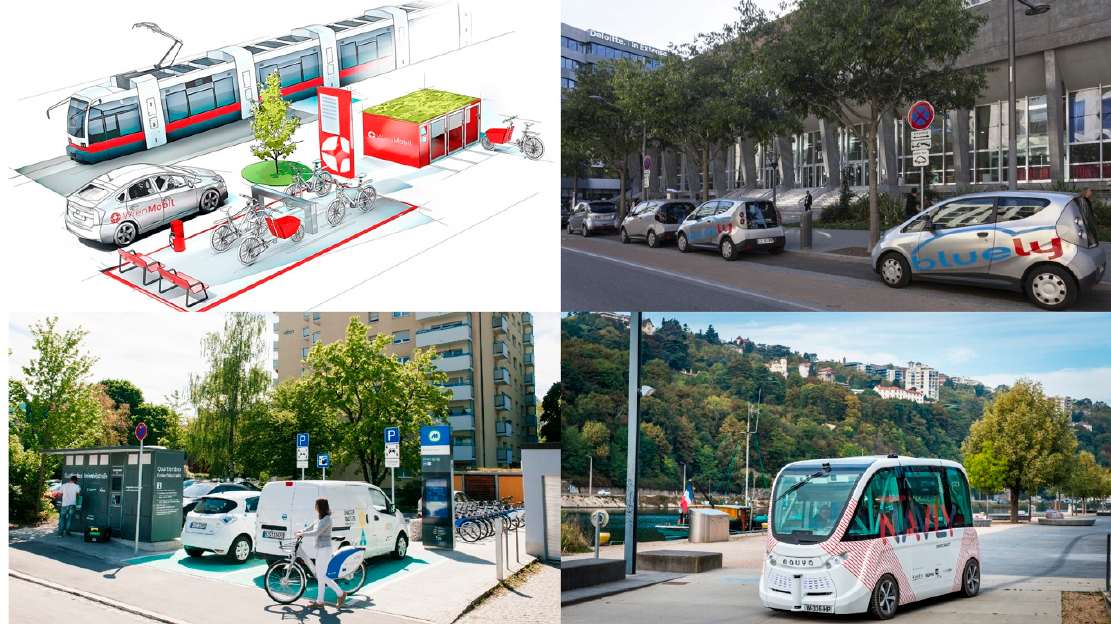
Figure 6. Clockwise from top-left, WienMobil Station at Simmeringer Platz, Wiener Linien [27]; NAVLY autonomous shuttle bus in Lyon, Laurence Danière (top-right), Bluely fleet at Bluely Station, Aurélie Pétrel (bottom-right); and Westkreuz Munich Mobility station, Dominik Parzinger.